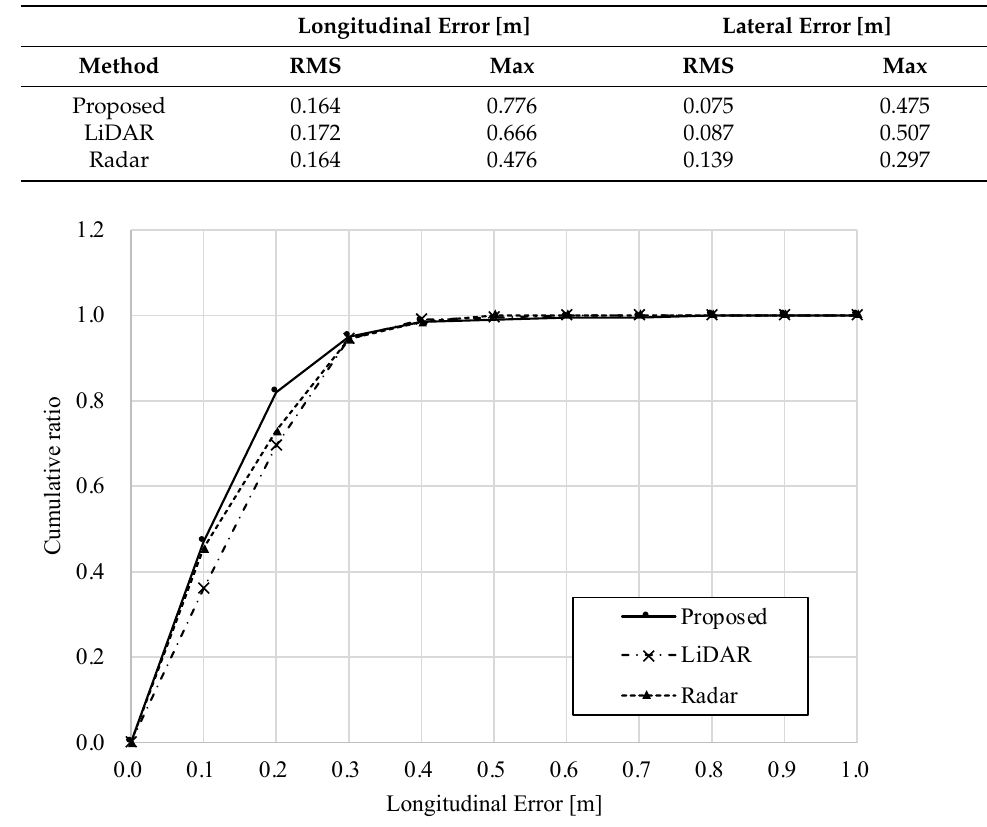
Table 4. RMS and max errors on dry road surface condition.